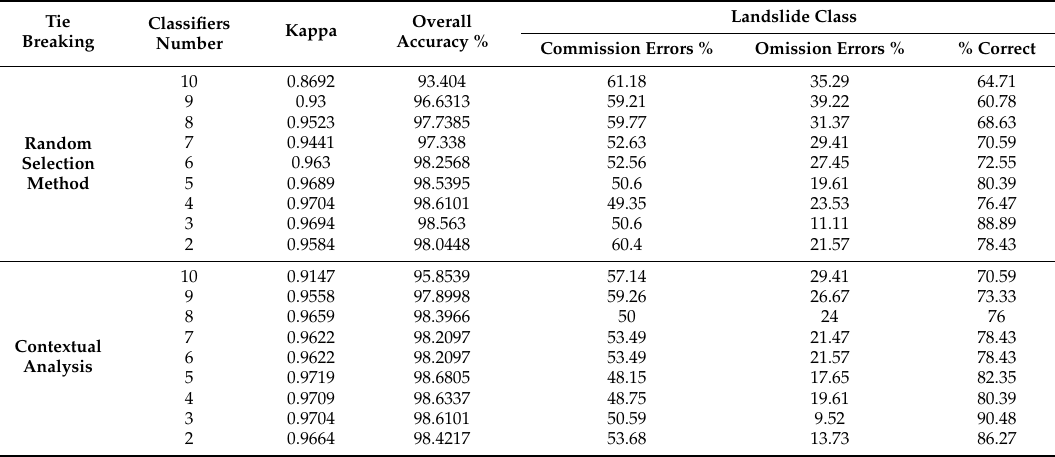
Table 3. Classifier ensembles accuracy evaluation.